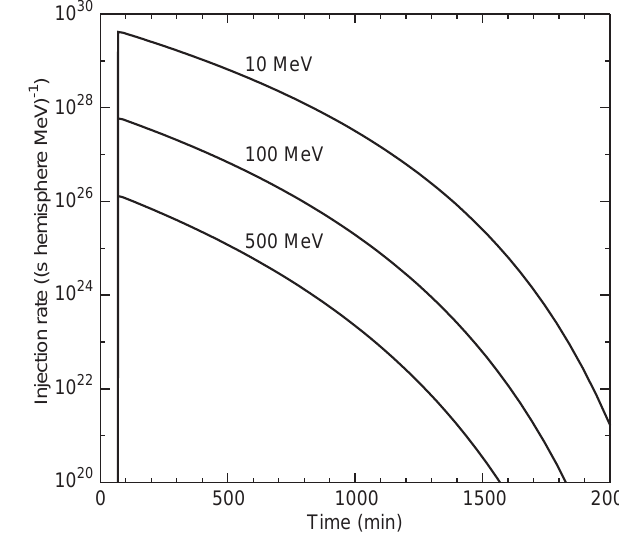
Fig. 6. As Fig. 5 but for the 22 October SEP event Fig. 7. As Fig. 5 but for the 24 October